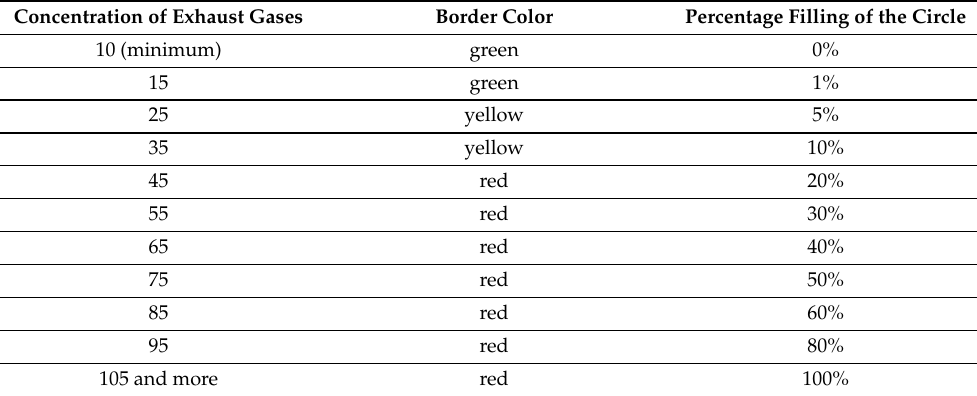
Table 3. Circle appearance according to the concentration of exhaust gases (in ppm). Concentration of Exhaust